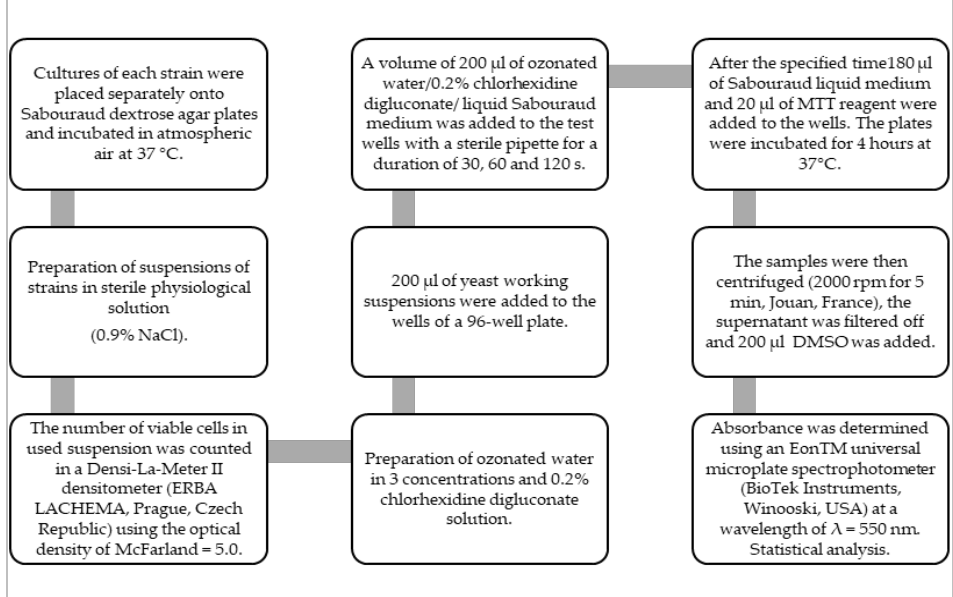
Figure 1. The study design .